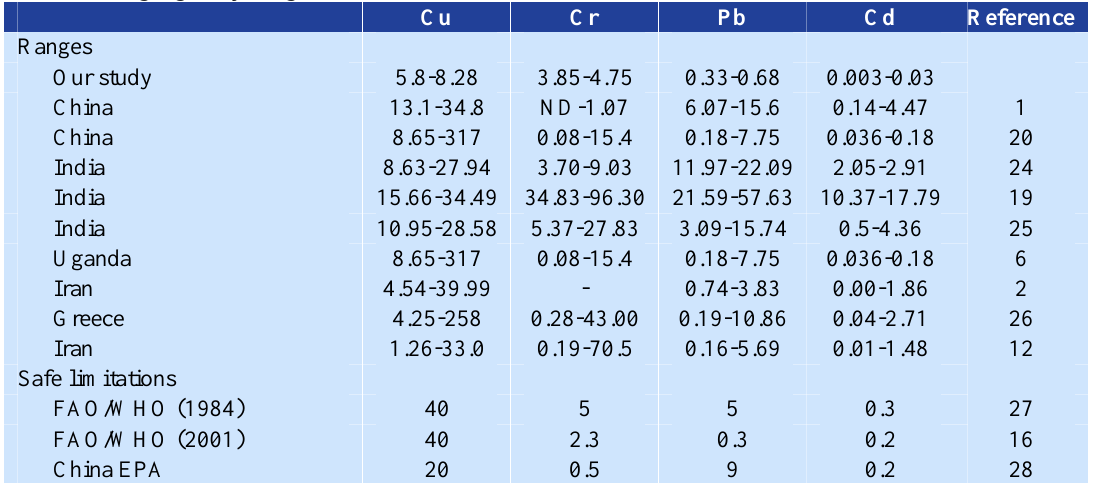
Table 5. Concentration ranges and safe limitations of heavy metals in vegetables from Iran and other countries (mg Kg -1 dry weight).